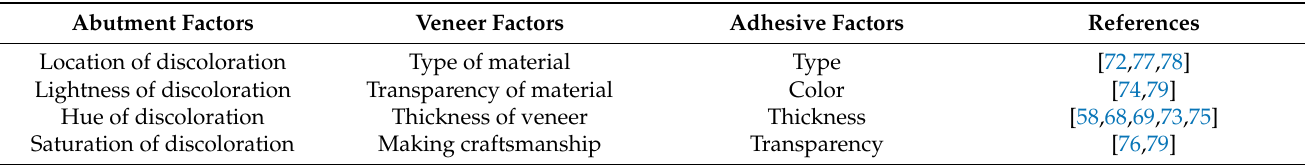
Table 4. The color-influencing factors that affect the effect of micro-veneer restorations.